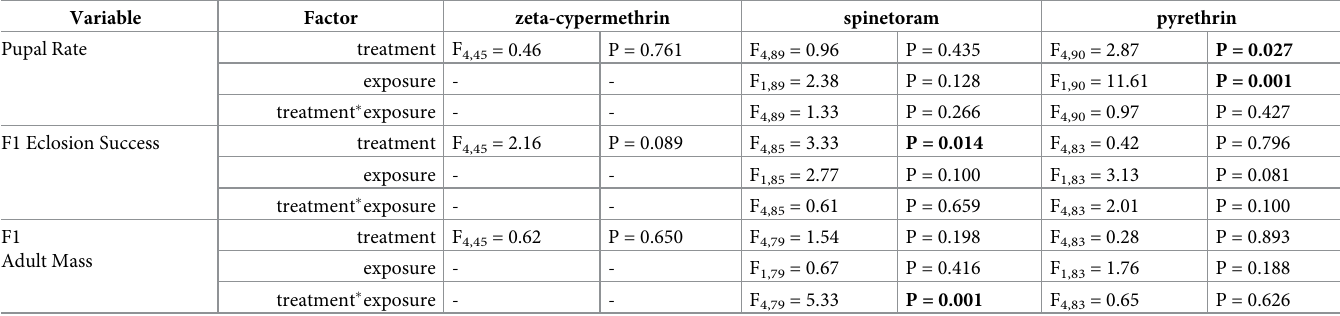
Table 4. Three-way ANOVA results for the effects of treatment concentration (LC 0 , LC 10, LC 20, LC 30, LC 40 ) and type of exposure (single or double) on female repro- duction, including pupal rate (pupae rate/female), the eclosion success of F1 offspring, and the average mass of F1 offspring for each insecticide experiment. Bolded values indicate statistically significant p-values (P �